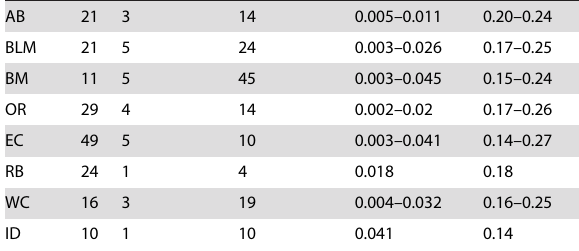
Table 2. The number of individuals included (N) in 2D LSA for each burned area: AB: Jasper National Park, Alberta; BLM: Black Mountain fire near Missoula, MT; BM: Boles Meadow fire near Missoula, MT; RB: Robert fire within Glacier National Park, MT; WC: Wedge Canyon fire within Glacier National Park, MT; ID: central Idaho; OR: Silver Lake, Oregon; EC: Eastern Canada, Que´bec Grands Jardins Park; the percent of individuals that had significant genetic clusters surrounding them, including the range of significance values and local genetic autocorrelation values ( lr ).